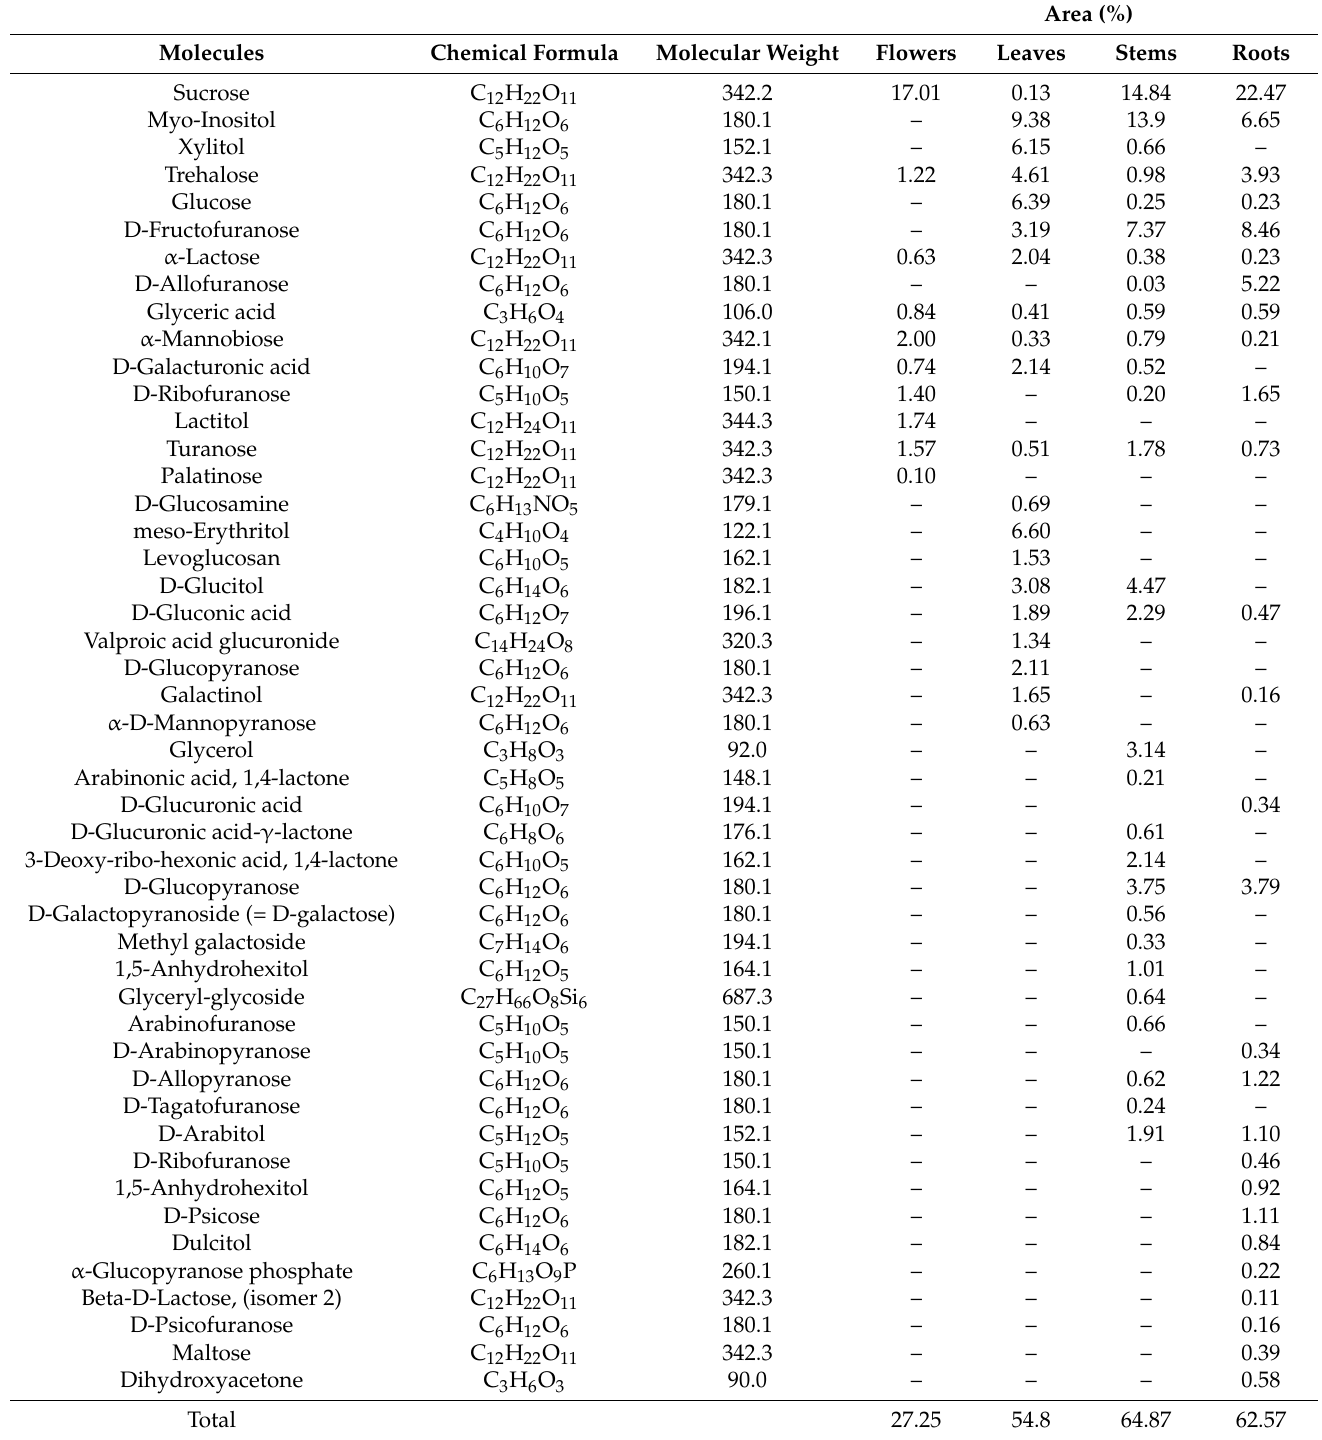
Table 3. Carbohydrate composition of derivatized methanolic extracts obtained by GC-MS.